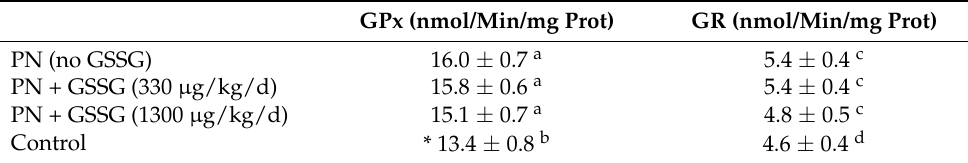
Table 1. Lung activities of Glutathione Peroxidase (GPx) and Glutathione Reductase